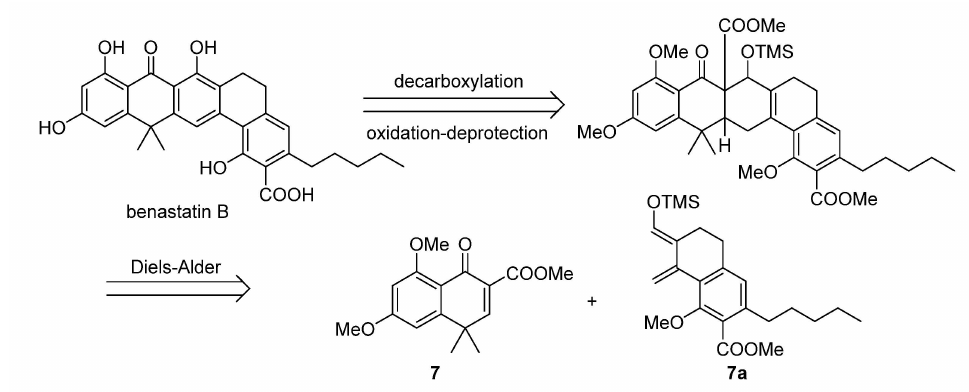
Figure 2. The retrosynthetic analysis of benastatin B through a plausible Diels–Alder approach.